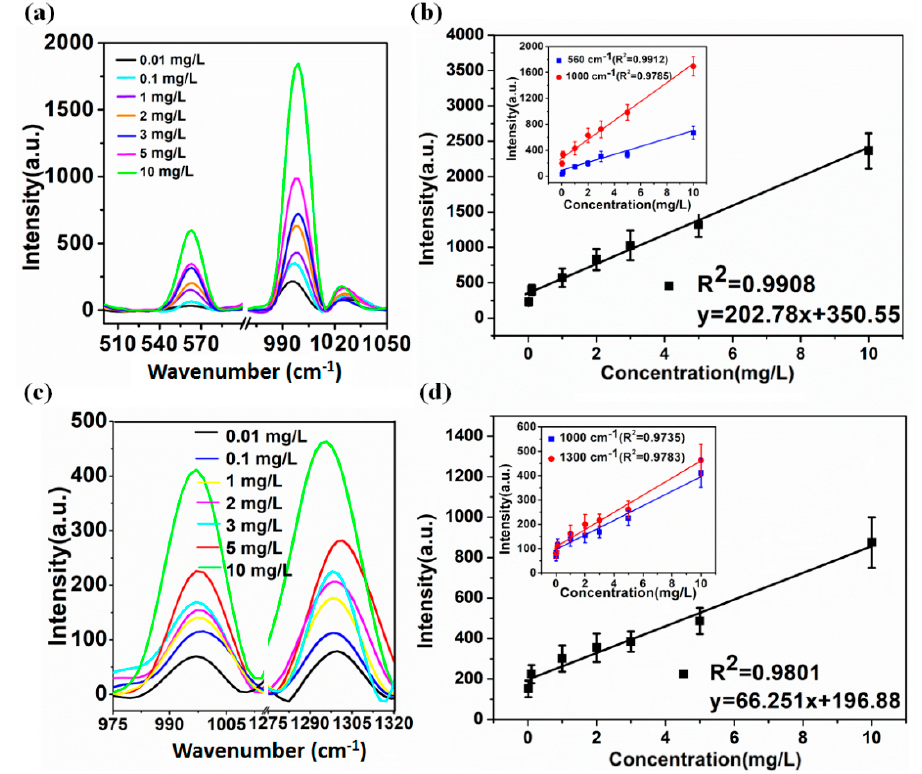
Figure 3. The RS of DM and CBF with its linear equation. ( a ) The RS of DM with AuNPs at different concentrations ranging from 0.01–10 mg/L; ( b ) the linear equation of Raman characteristic peak intensity and its concentration at 560 and 1000 cm − 1 of the DM molecule; ( c ) the RS of CBF with AuNPs at different concentrations ranging from 0.01–10 mg/L; ( d ) the linear equation of Raman characteristic peak intensity and its concentration at 1000 and 1300 cm − 1 of the CBF molecule.